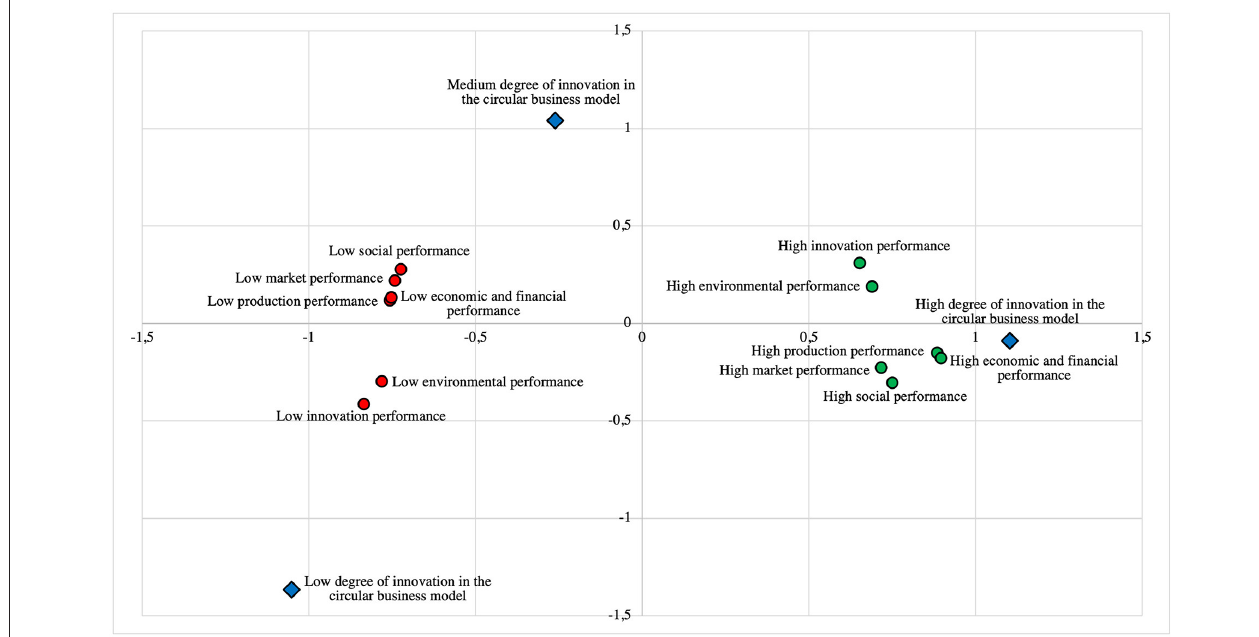
FIGURE 3 | Analysis of correspondence among